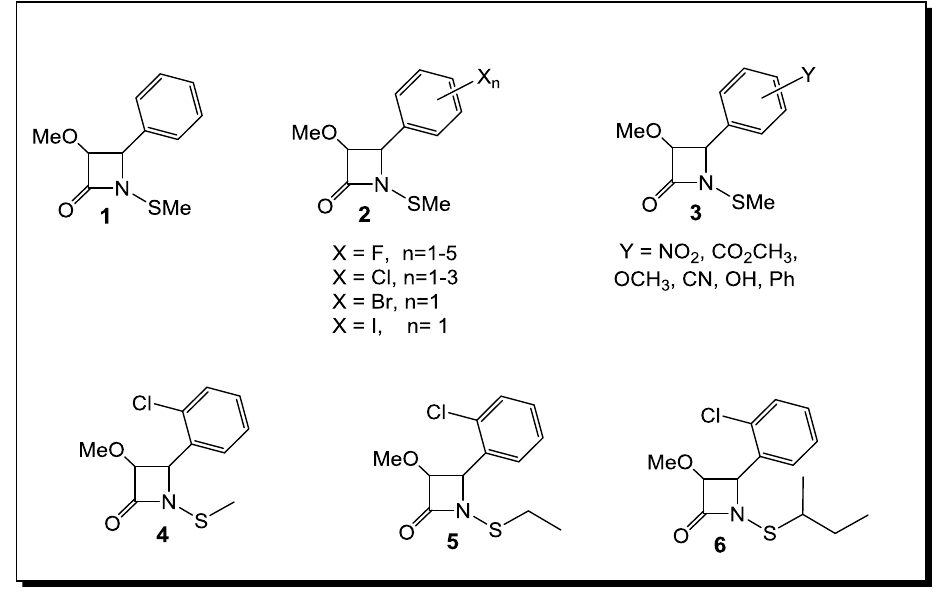
Figure 3. N -alkylthio β-lactams active against Staphylococcus spp . (including methicillin- resistant S. aureus (MRSA)) and Bacillus spp